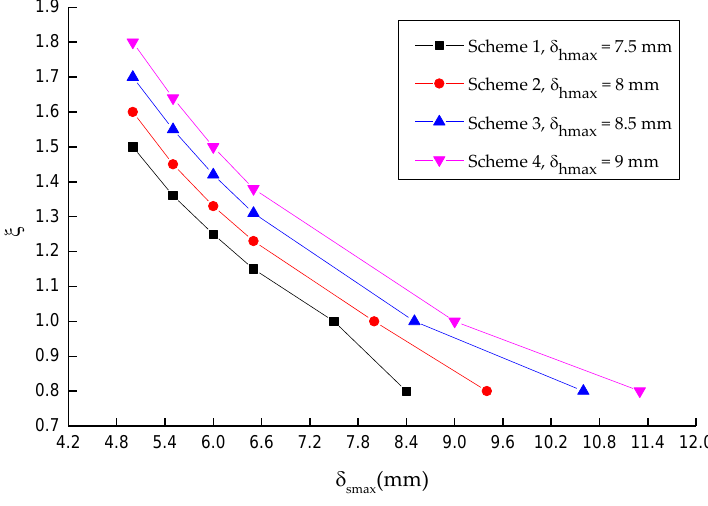
Figure 10. Thick airfoil schemes.